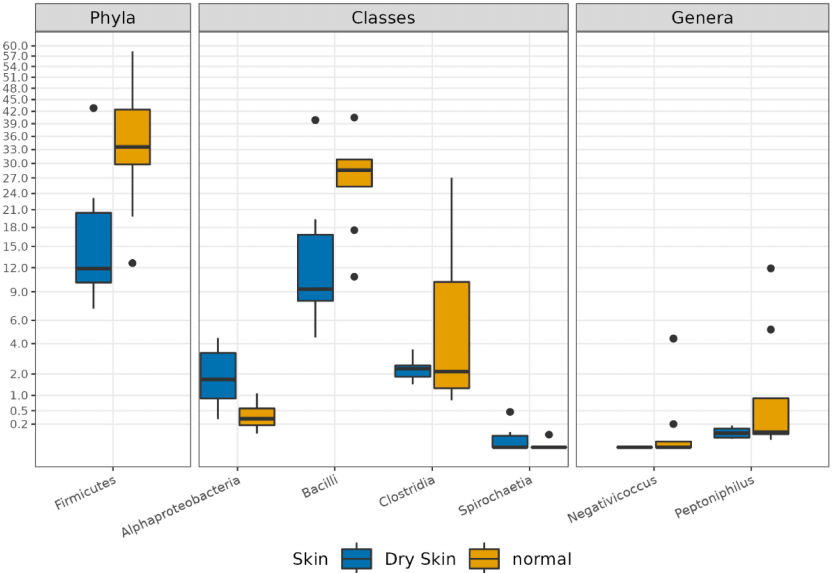
Figure 10. Boxplot showing the results of taxa differential abundance analysis between the dry skin and normal skin groups. Y axis has been scaled to improve the readability of values. All results have an adjusted p -value < 0.05.